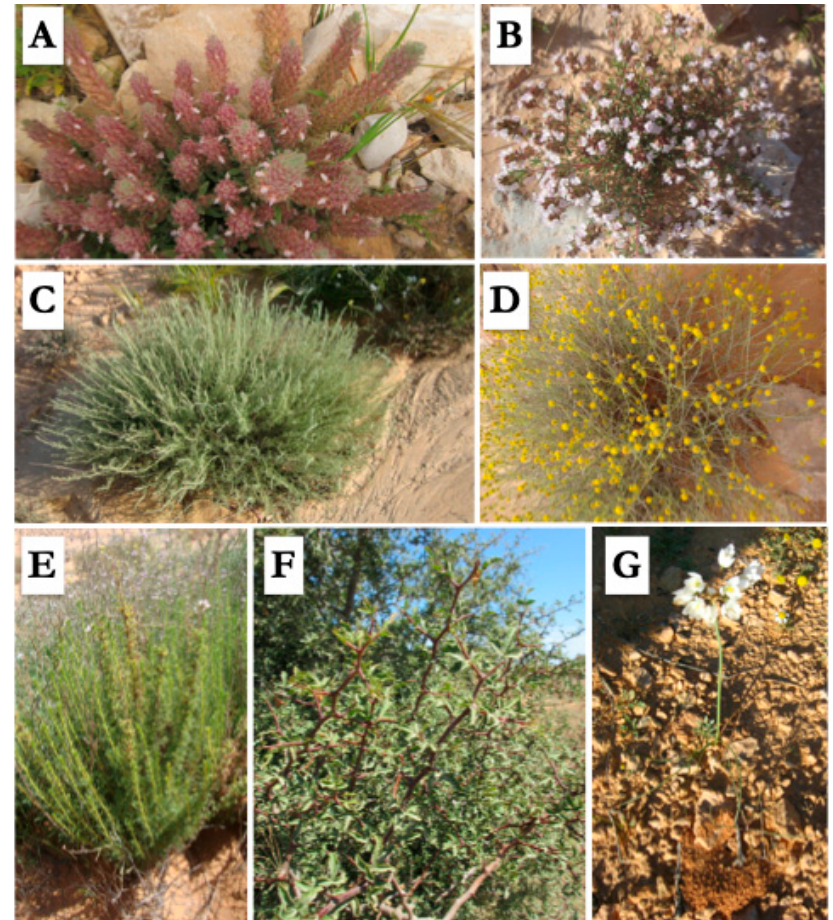
Figure 1. Some endemic taxa inventoried in the study area. Photos ( A ): Teucrium alopecurus de Noé; ( B ): Thymus algeriensis Boiss. & Reut.; ( C ): Artemisia saharae Pomel ; ( D ): Rhanterium suaveolens Desf.; ( E ): Artemisia campestris L. subsp. cinerea Le Houér; ( F ): Searsia tripartita (Ucria) Moffett; ( G ): Allium roseum L. subsp. odoratissimum (Desf.) Murb.